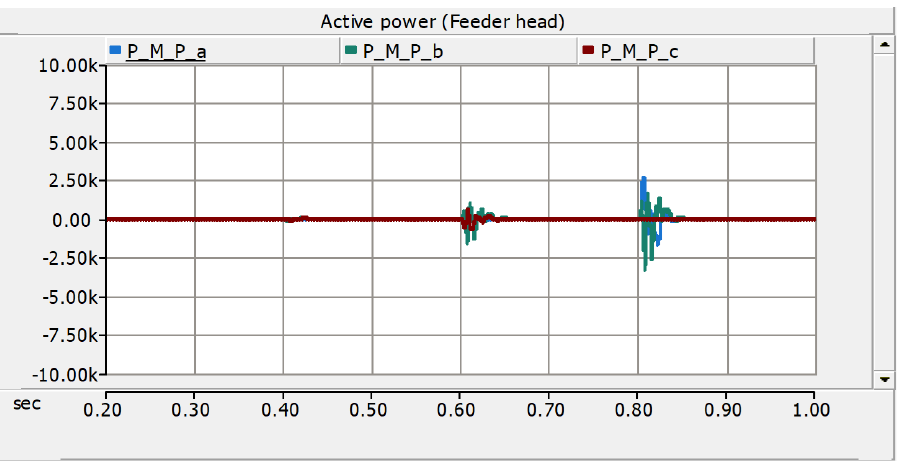
Figure 12. Feeder head active power shows that the power is shared between the multimicrogrid system effectively without requiring the power from the feeder head.